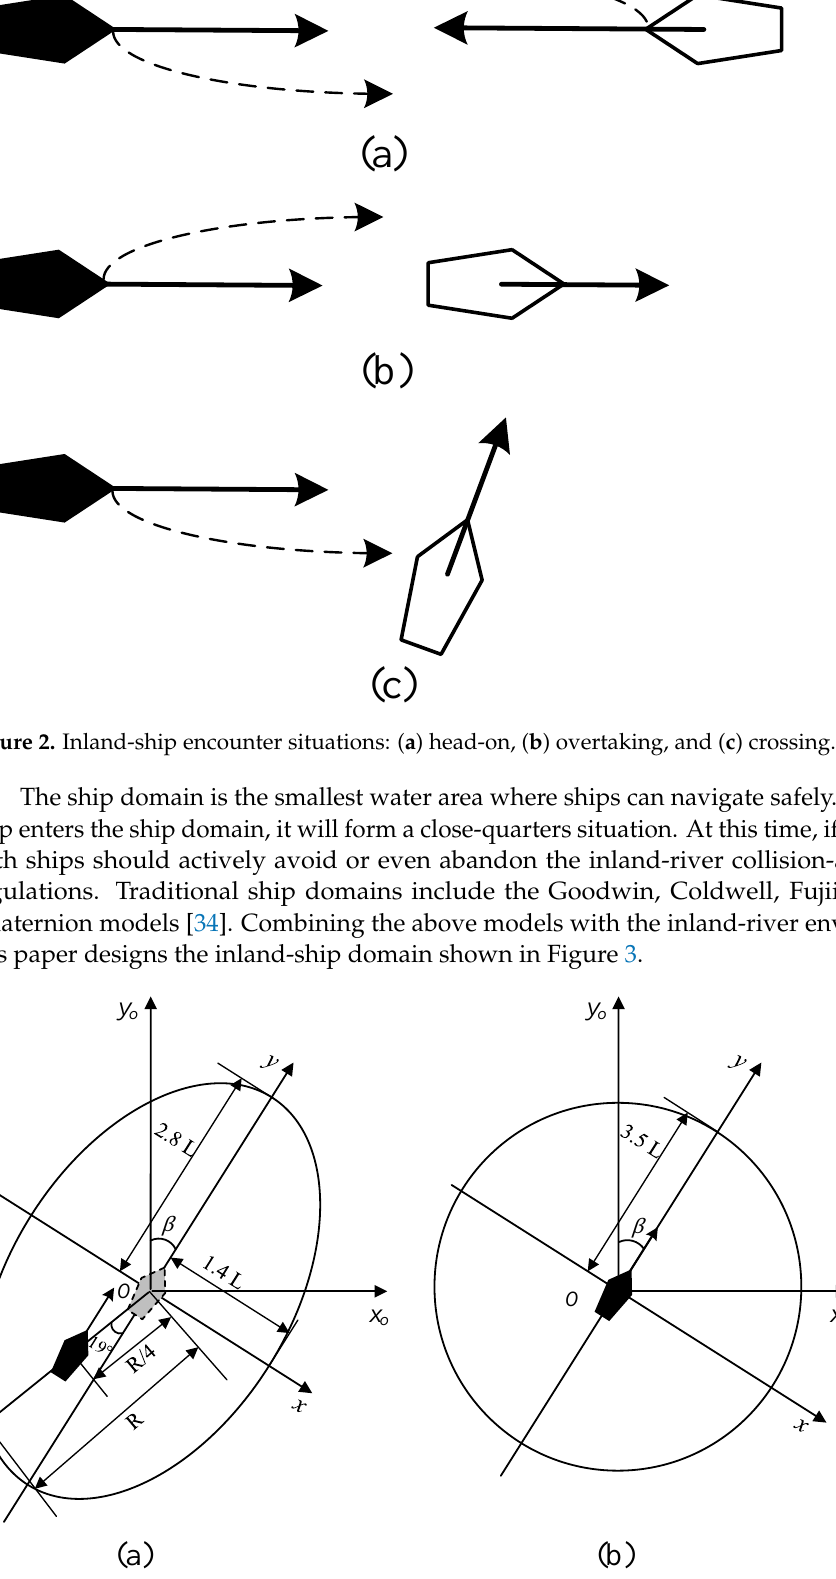
(b) Figure 3. Inland-ship domain for: ( a ) dynamic obstacles, ( b ) static obstacles.